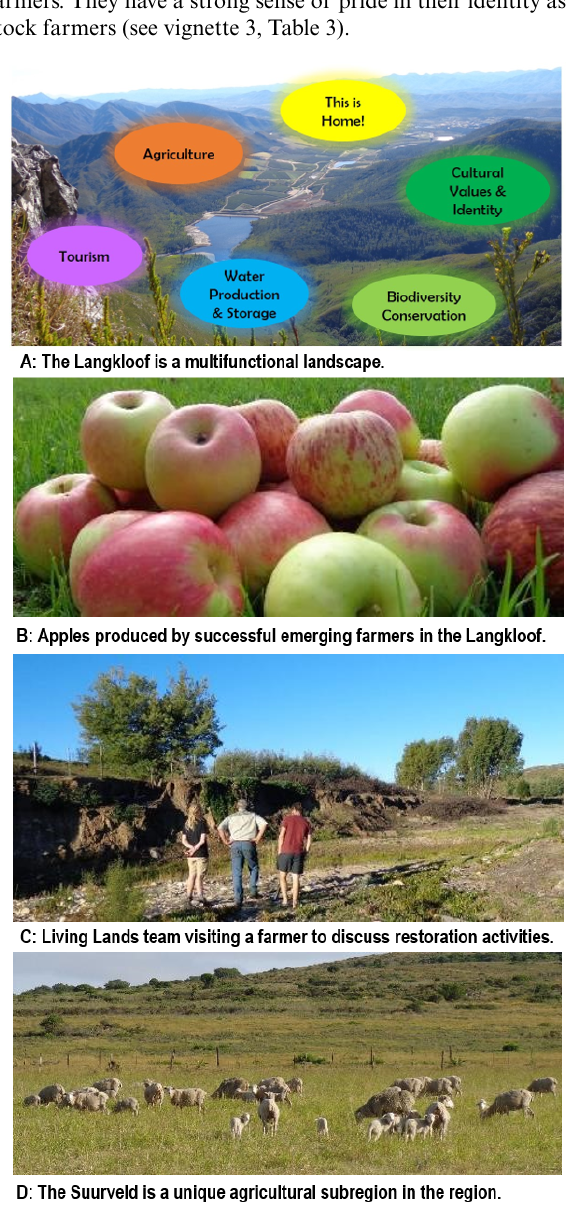
Fig. 2 . Scenes from the Langkloof region: A: View of the Langkloof from the highest peak in the Langkloof mountain range (Formosa Peak), looking north-west toward the settlement of Louterwater. Each oval indicates a specific land use or function in the landscape, thus the Langkloof can be considered a multifunctional landscape. B: These apples were given to the lead author by one of the successful emerging farmers in the Langkloof (see vignette 1, Table 3). C: Members